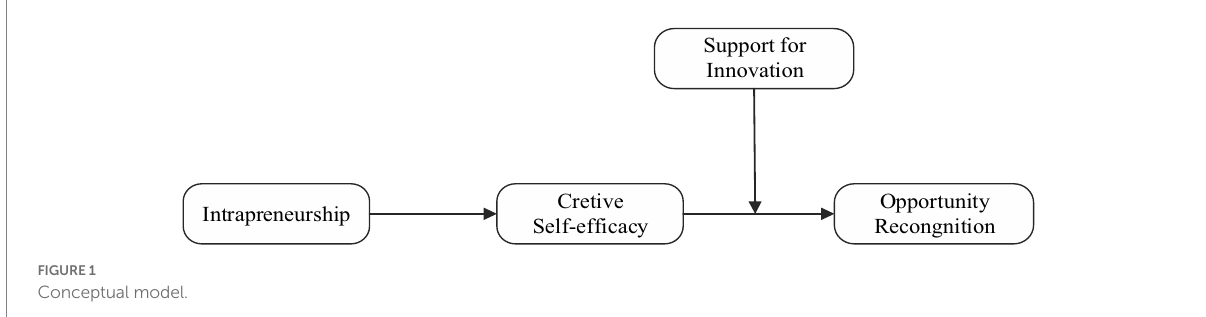
FIGURE 1 Conceptual